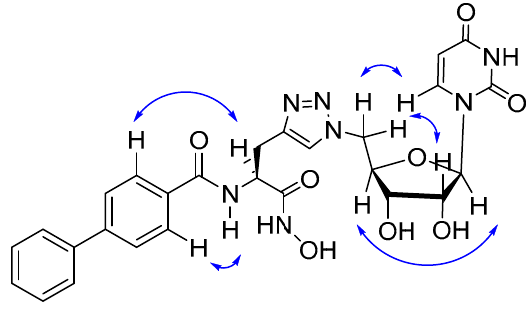
Figure 4. Key NOESY correlations of 4 .